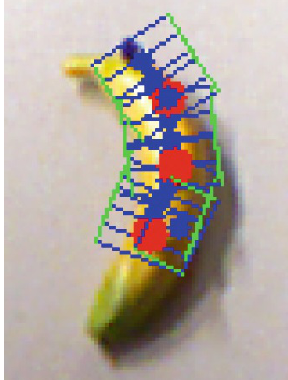
Figure 11. Marker based evaluation method